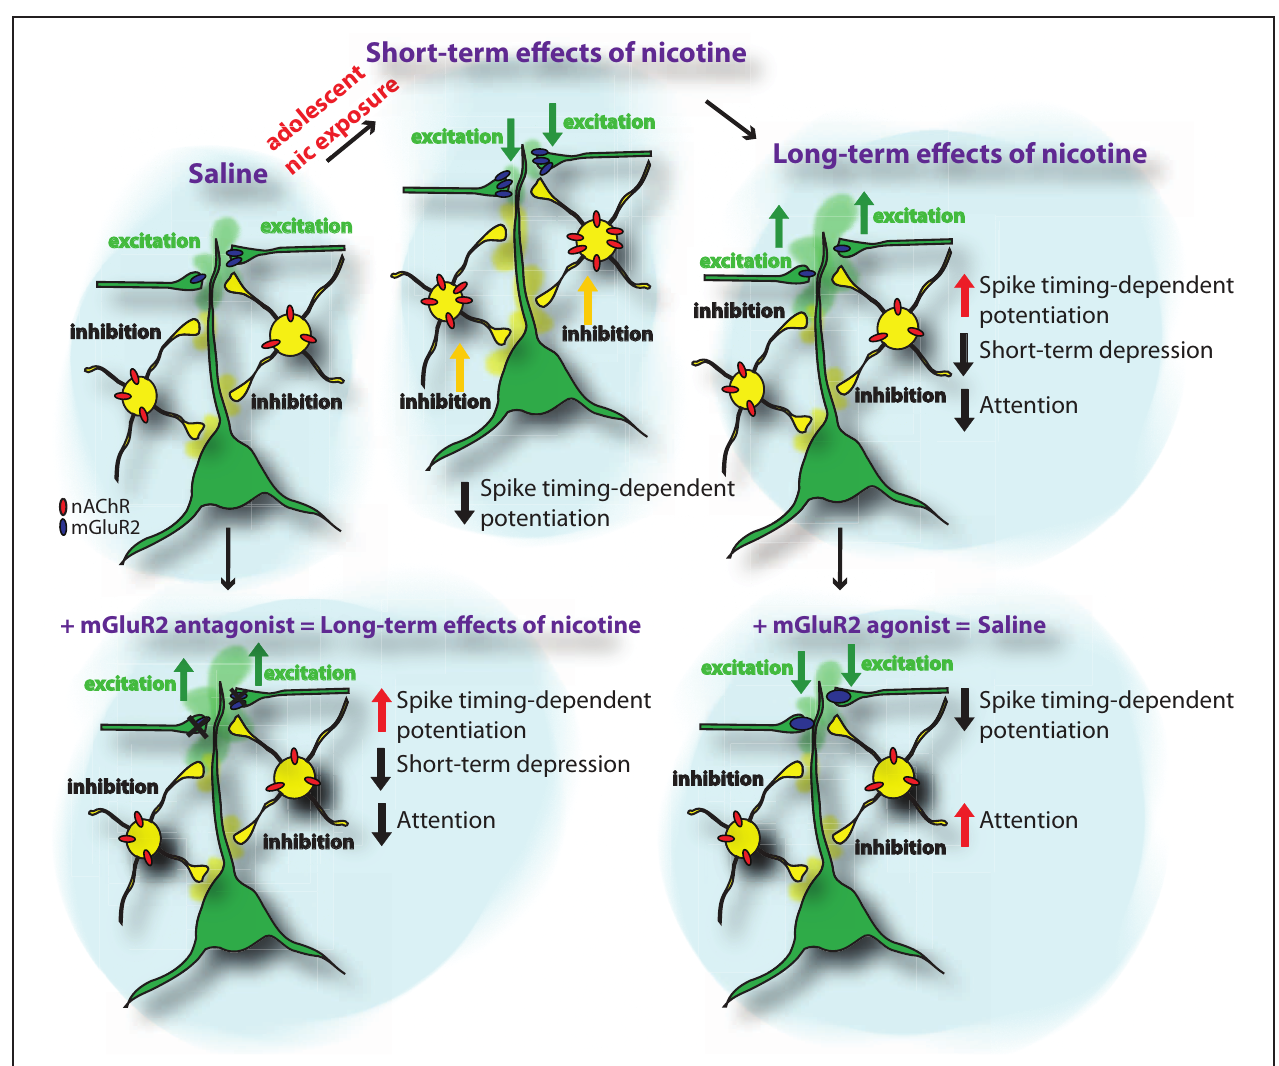
show the effects of mGluR2 agonists and antagonists in saline and nicotine-exposed animals. Applying mGluR2 antagonists to the adult mPFC reduces depression of glutamatergic synapses and reduces attention performance of the animal. Providing mGluR2 agonists to the mPFC of adult rats that were exposed to nicotine during adolescence normalizes synaptic depression and spike-timing-dependent potentiation of glutamatergic synapses and improves attention